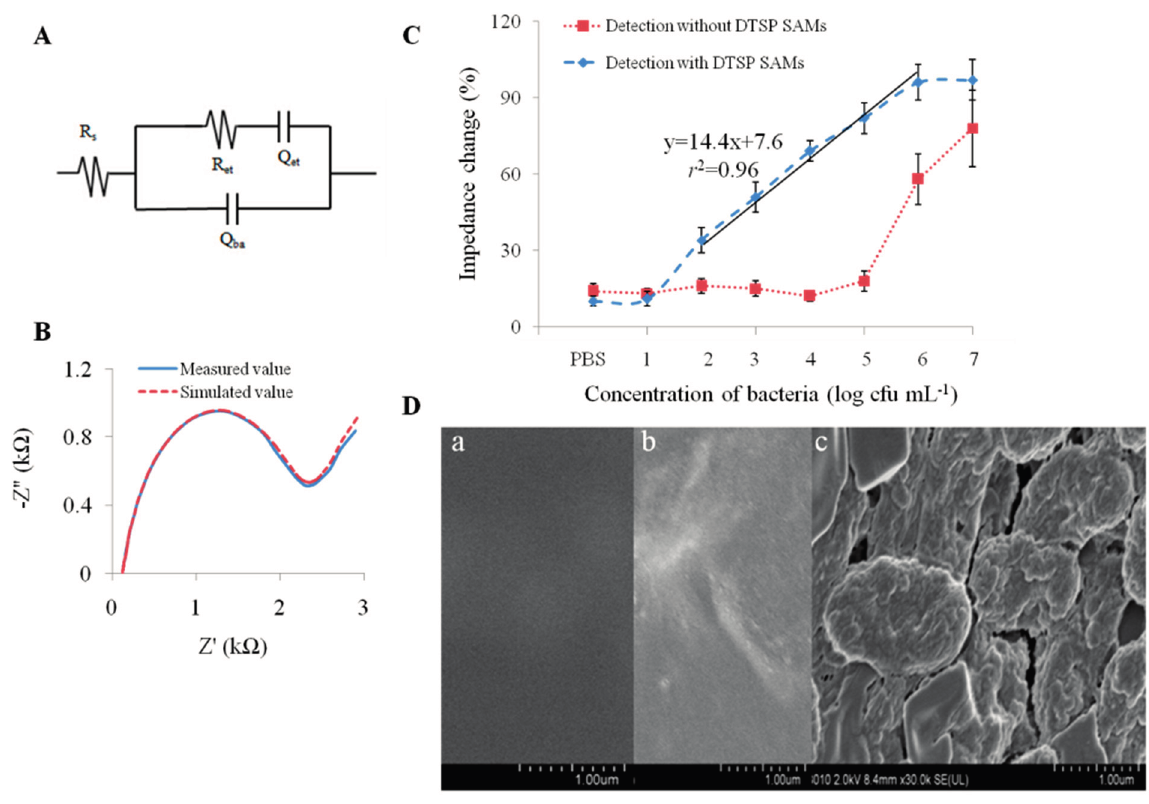
Figure 5. ( A ) The plot of the measured and simulated data using the immunosensor with DTSP SAMs; ( B ) A modified Randles’ equivalent circuit; ( C ) The detection of E. coli O157:H7 at different concentrations using the immunosensor with DTSP SAMs or not; ( D ) Characterization of the surface of the bare SPIM ( a ), the surface of the SPIMs before ( b ) and after ( c ) the bacteria incubation by scanning electron